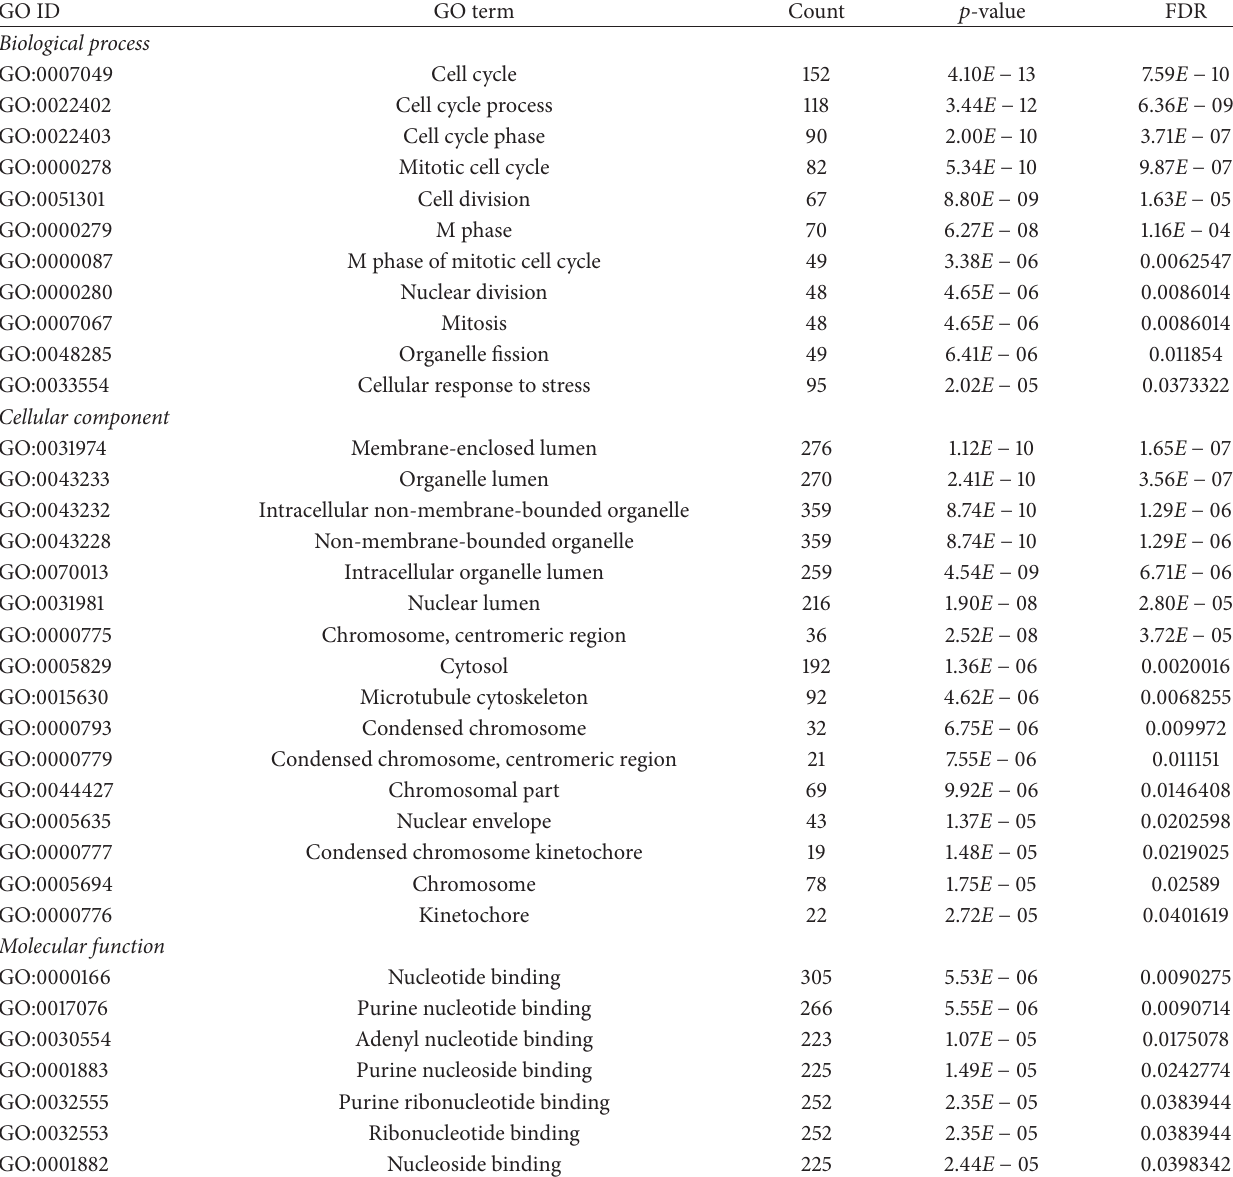
Table 3: GO annotation of upregulated DEGs in